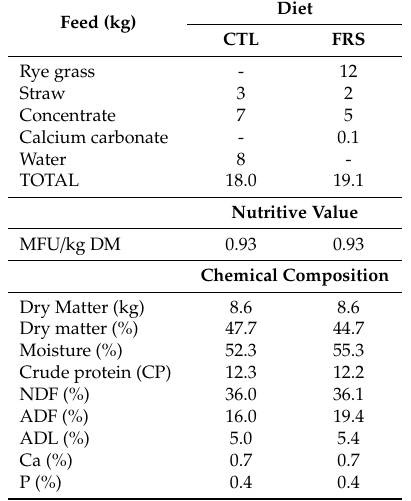
Diet Feed (kg) CTL FRS Rye grass - 12 Straw 3 2 Concentrate 7 5 Calcium carbonate - 0.1